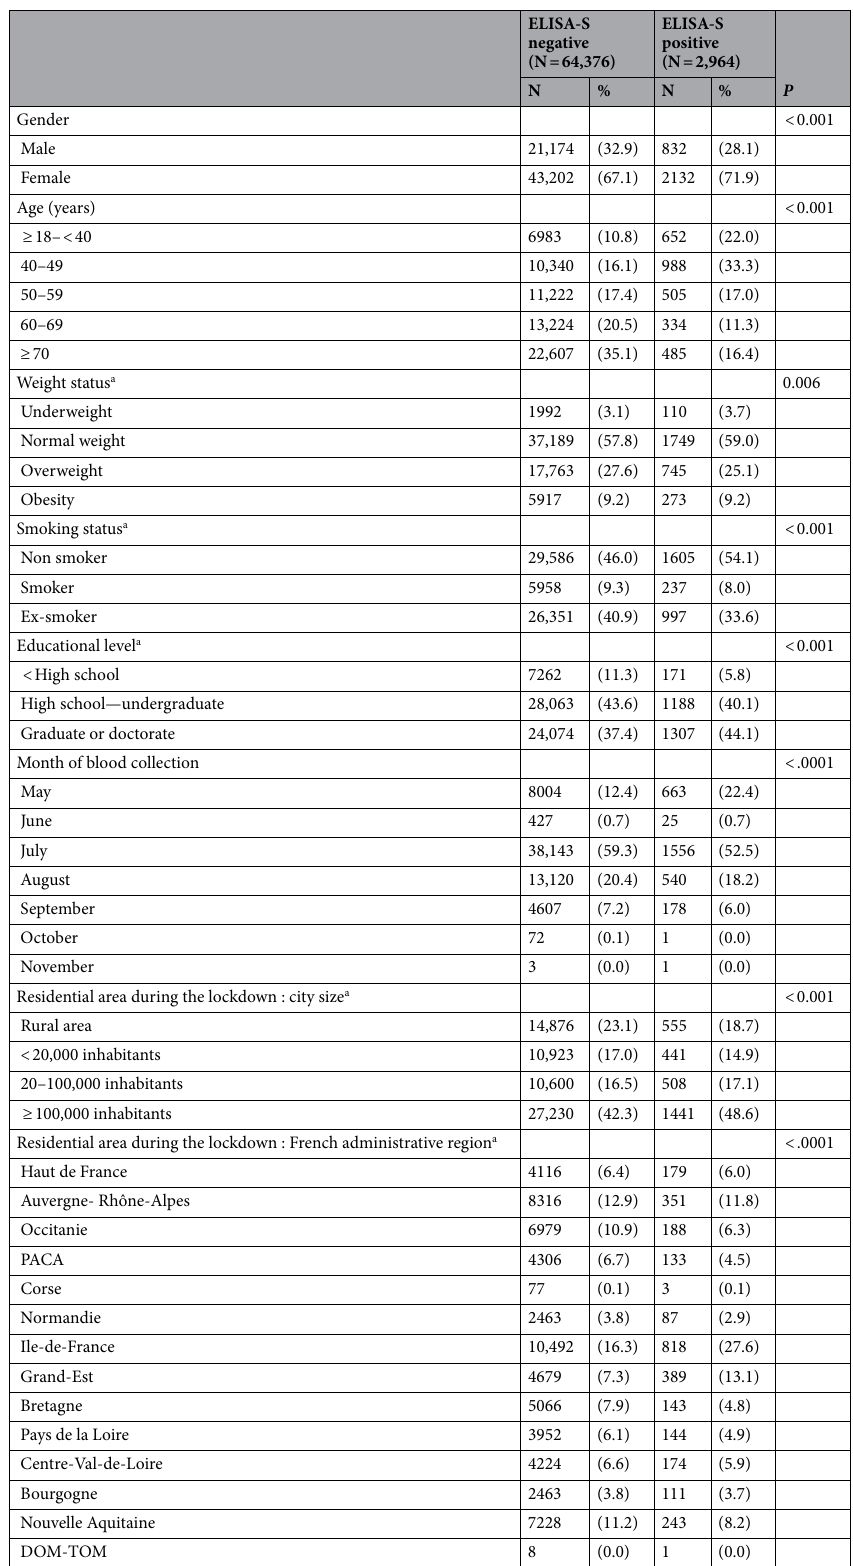
Table 1. Characteristics of the population, SAPRIS-SERO multi-cohort study, 2020. a Missing values: N = 1602 (2.4%) for weight status, N = 2606 (3.9%) for smoking status, N = 5275 (7.8%) for educational level, N = 766 (1.1%) for city size and N = 7 (0.01%) for French administrative